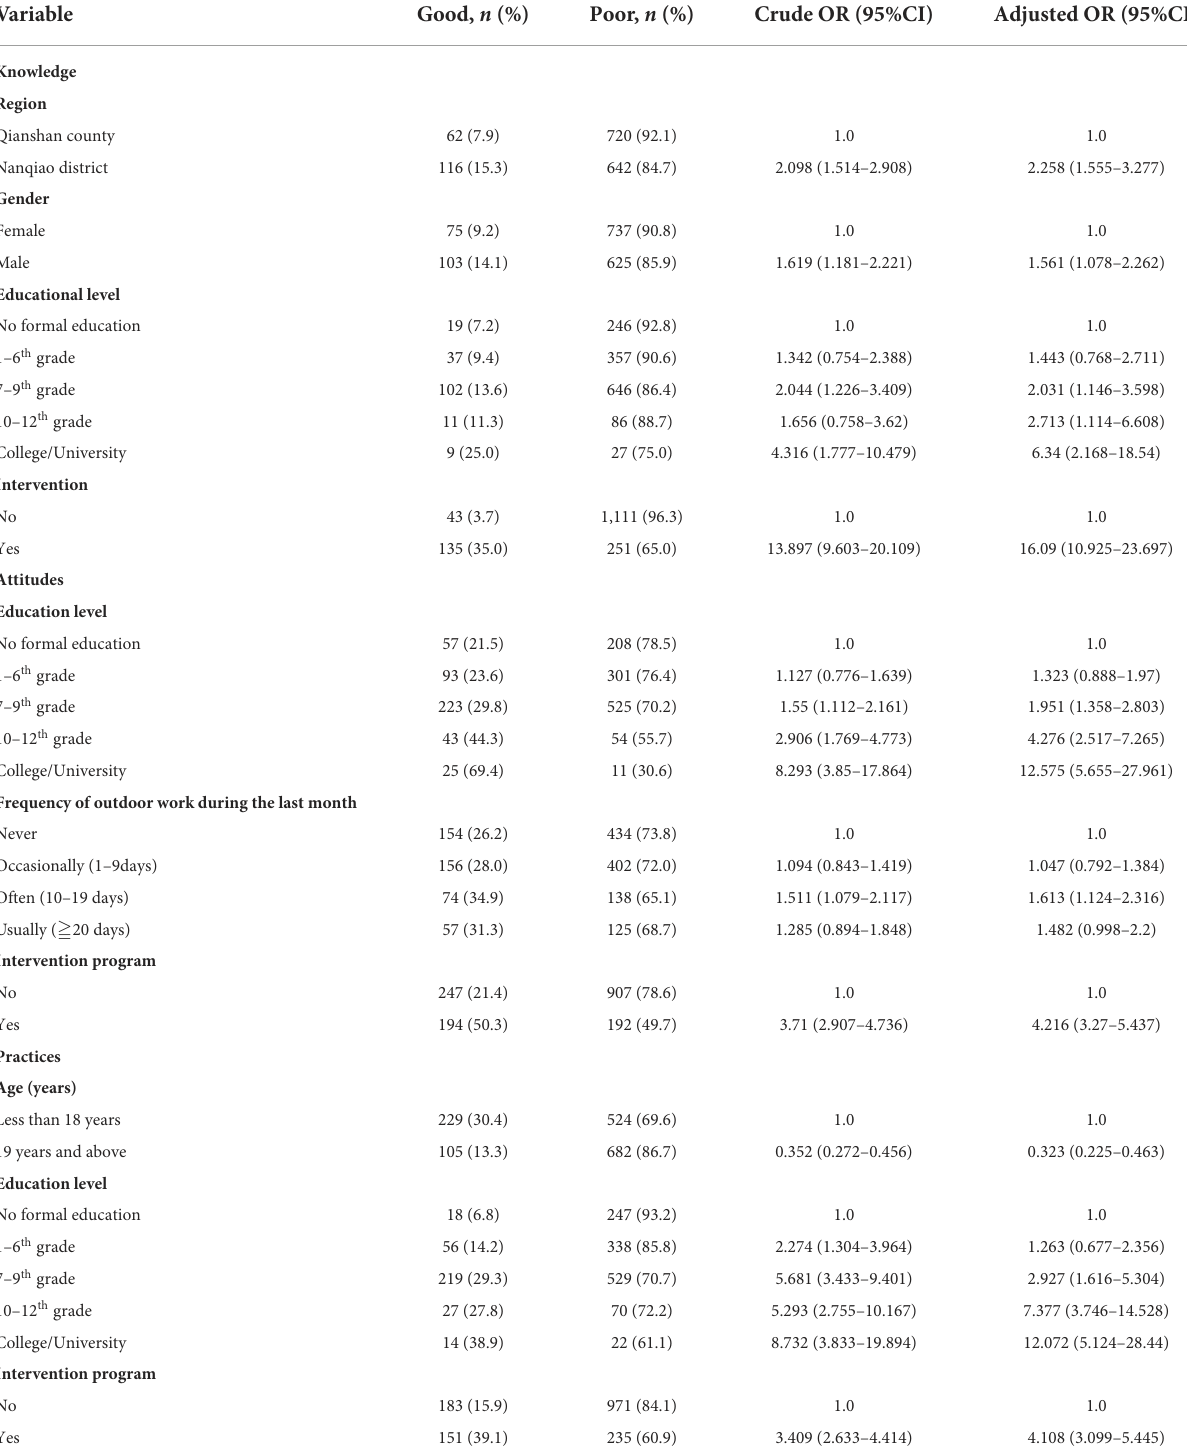
TABLE 4 Predictors of good knowledge, attitude, and practice